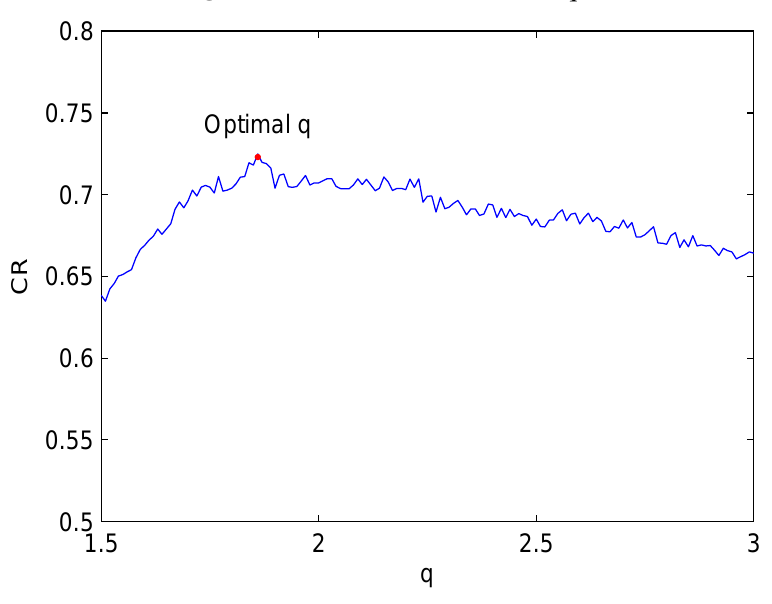
Figure 9. The curve of CR with q